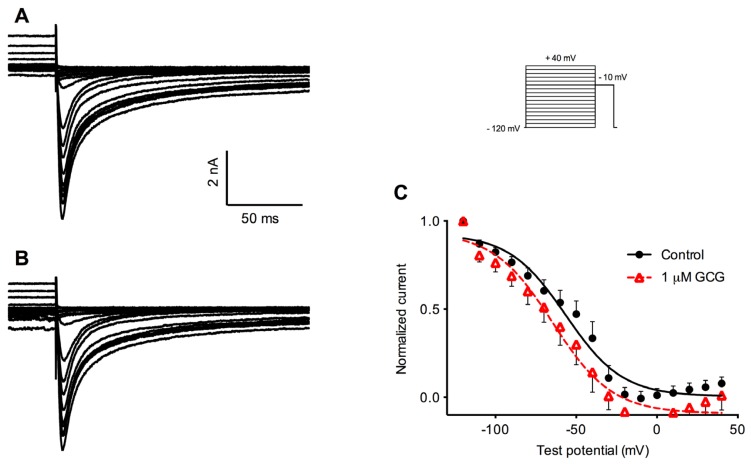
Effects of GCG on the steady-state inactivation of tetrodotoxin-resistant Na+ currents. (A,B) Original recordings of tetrodotoxin-resistant Na+ currents elicited by depolarizing to −10 mV after a 1.5 s conditioning prepulse ranging from −120 mV to +40 mV under control condition (A) and after treatment with 1 μM GCG for 5 min (B); (C) Steady-state inactivation curves in control (filled circles) and in the presence (unfilled triangles) of 1 μM GCG (n = 5).